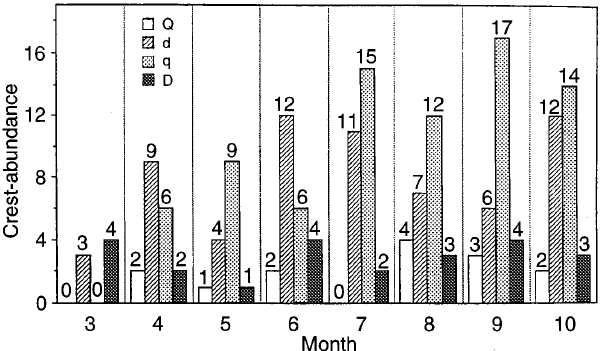
Fig. 5. Histograms of monthly crest abundances distributed into four magnetic activity ranges according to the relevant sums of 8 three- hourly am indices (between noon on the previous day and noon on the day considered: Q (cid:133) very quiet (cid:134) : a m < 20 d (cid:133) moderately active (cid:134) : 20 (cid:20) a m > 30 (sampling interval